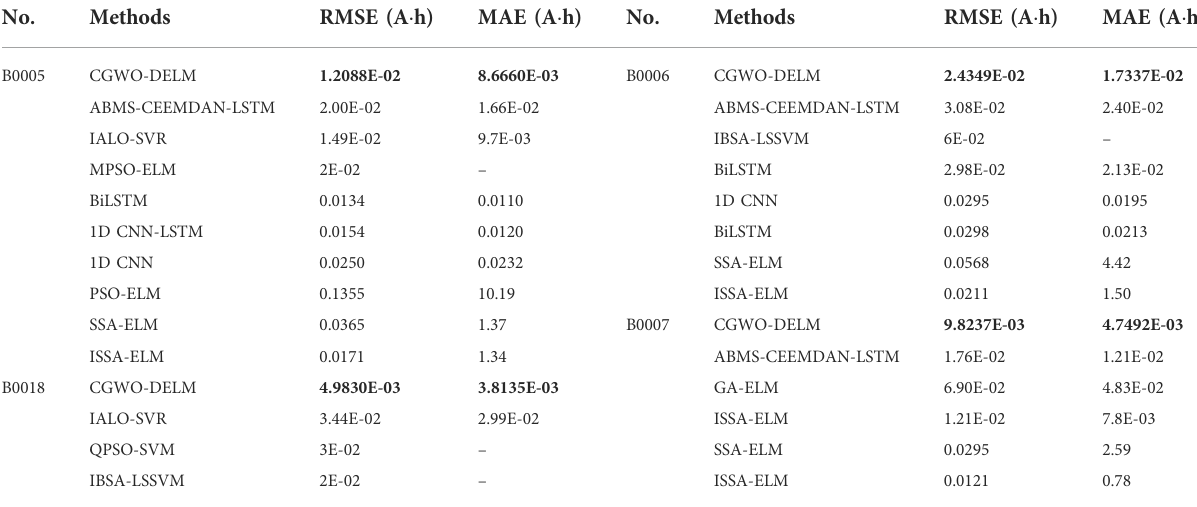
TABLE 8 Comparison results between CGWO-DELM and other prediction methods.